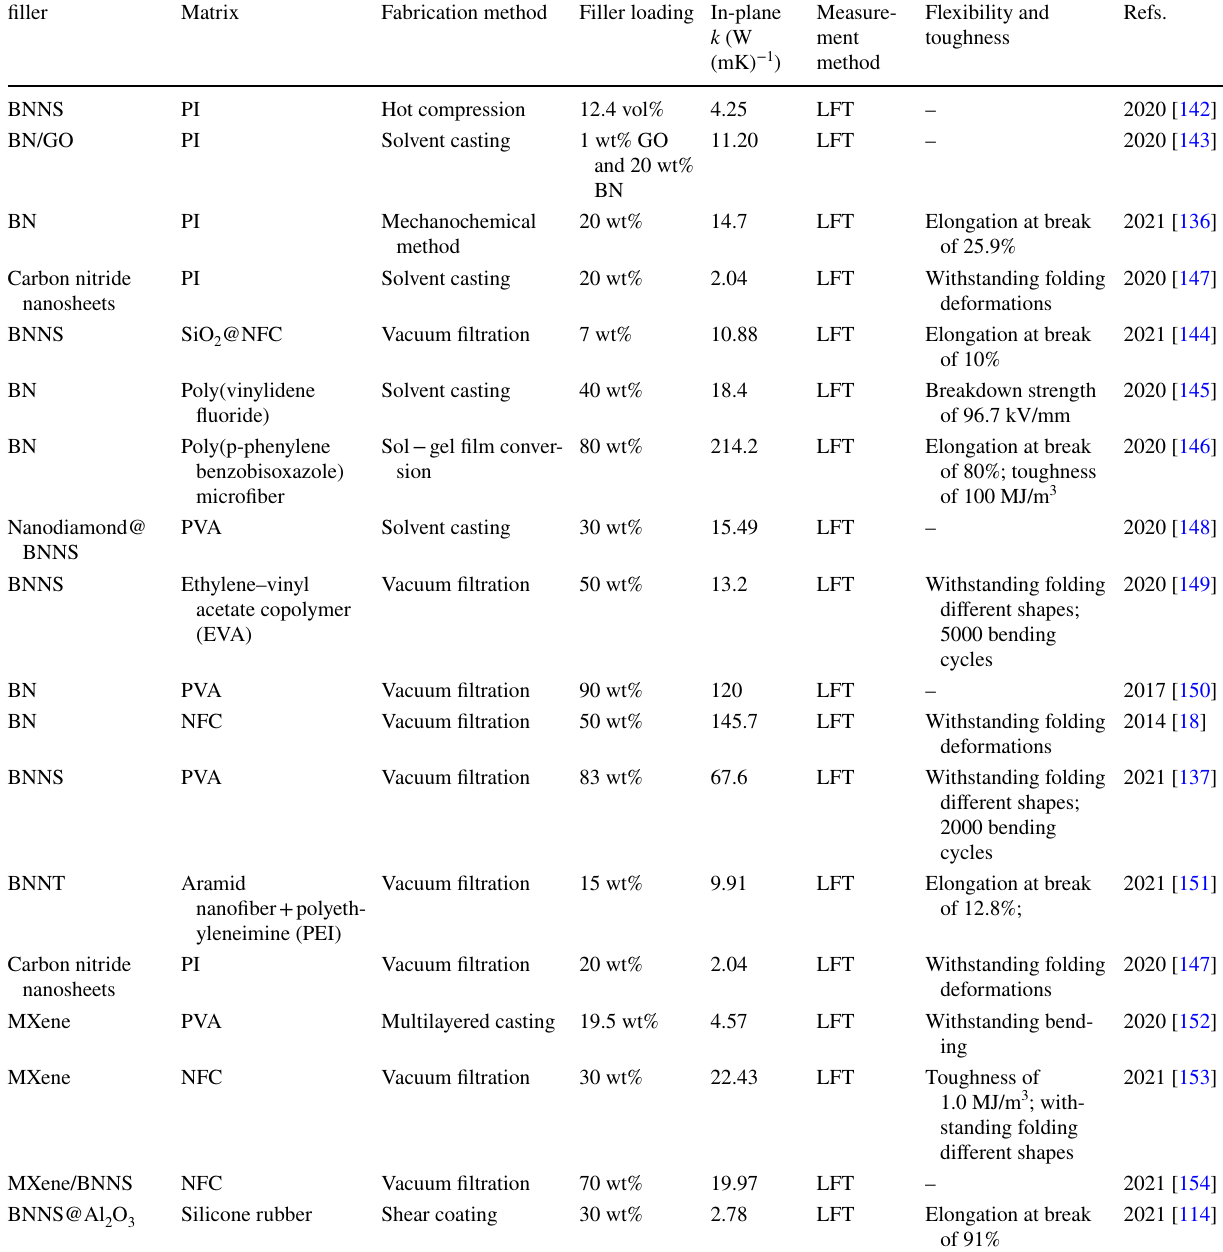
Table 5 The summary of thermally conductive ceramic/polymer composite films filler Matrix Fabrication method Filler loading In‑plane